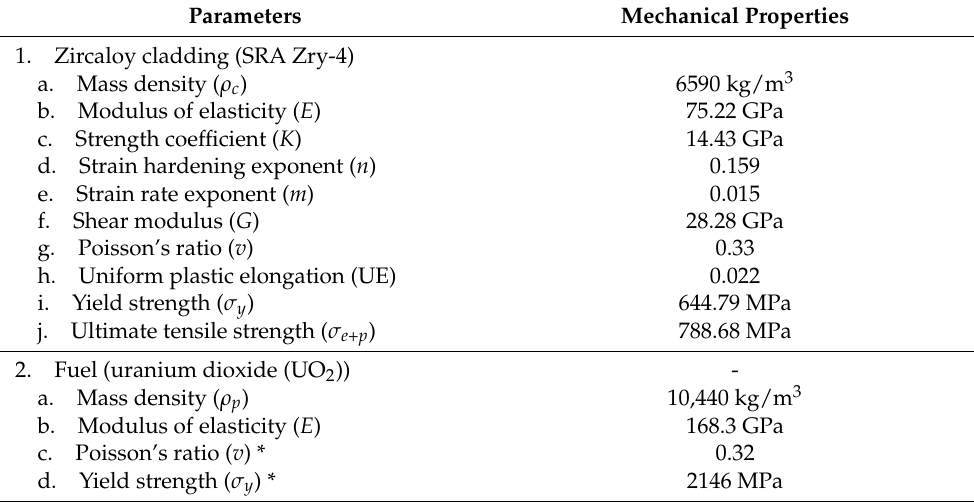
Table 2. Mechanical parameters of the fuel rod model. Reprinted with permission from ref. [11].